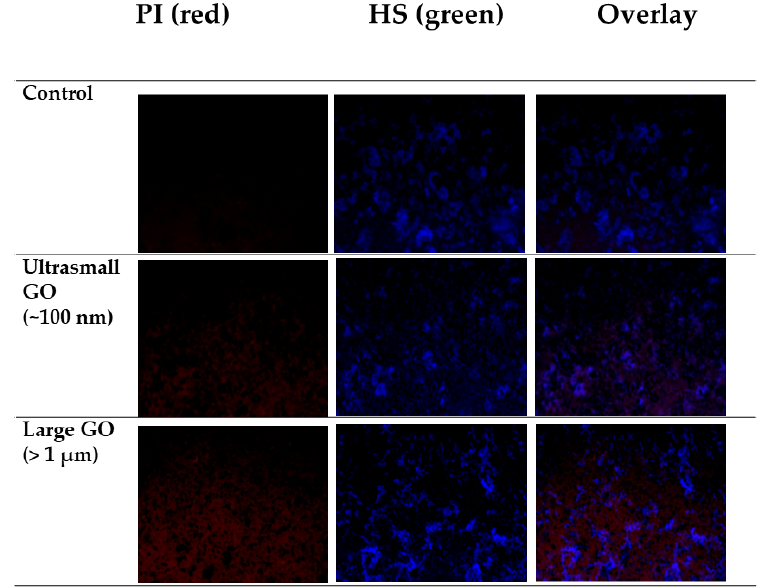
Figure 8. Live/dead cell staining by PI and HS of E. coli control culture and cultures subjected to treatments with >1 µm and ~100 nm GO.